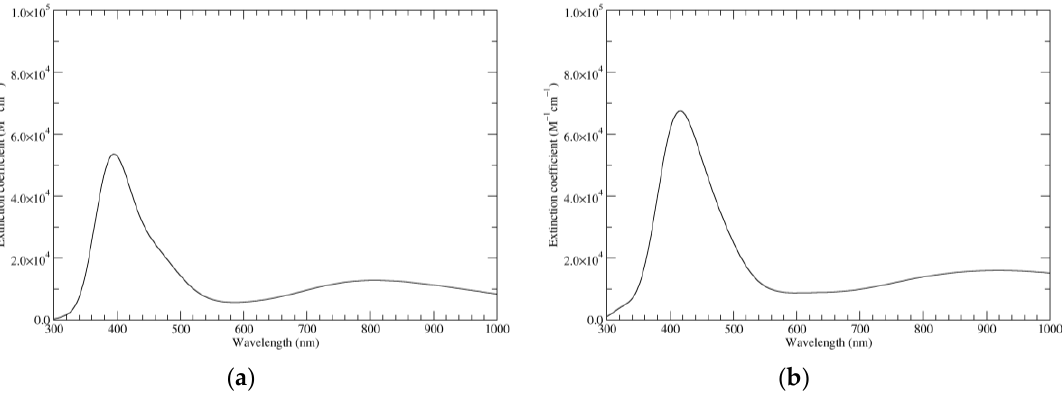
Figure 11. Computed UV–Vis spectra of the most significant tautomers/conformers in the eight-electrons oxidation state. ( a ) Neutral form in vacuo, a16_b56_c16_d56, C 2 , conf1. ( b ) Neutral form in water, a16_b56_c16_d56, C 2 , conf1.